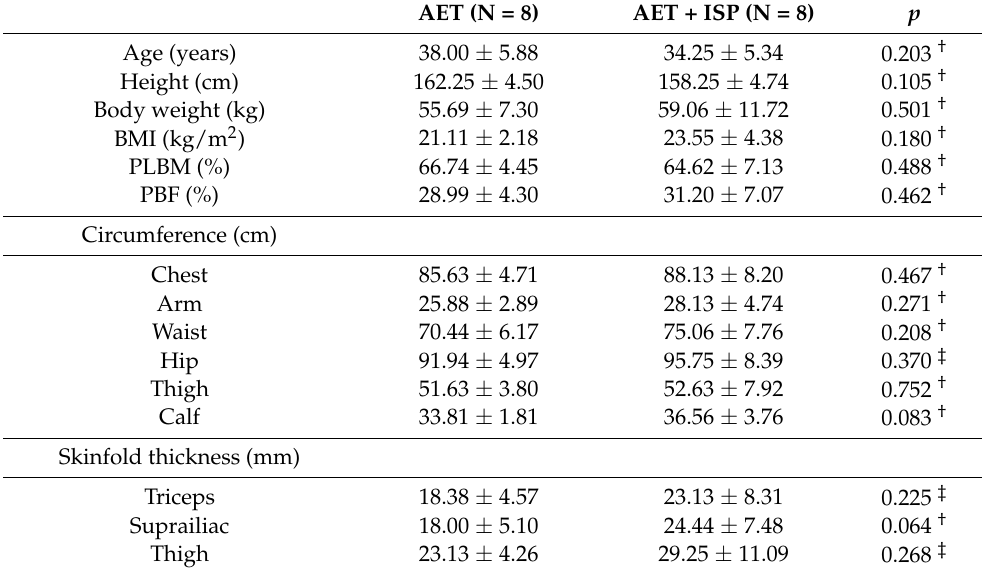
Table 2. Subjects’ baseline information in the AET and AET + ISP